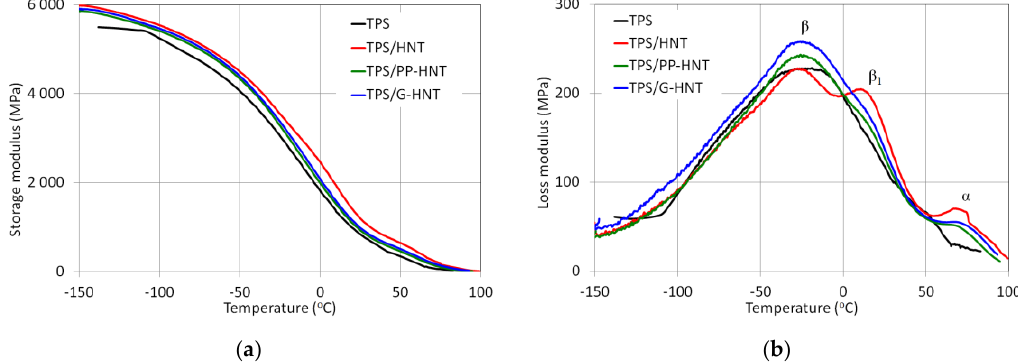
Figure 8. Storage modulus ( a ) and loss modulus ( b ) of unmodified and halloysite-modified TPS. Table 3. Storage modulus and relaxation temperature of unmodified and halloysite-modified TPS.